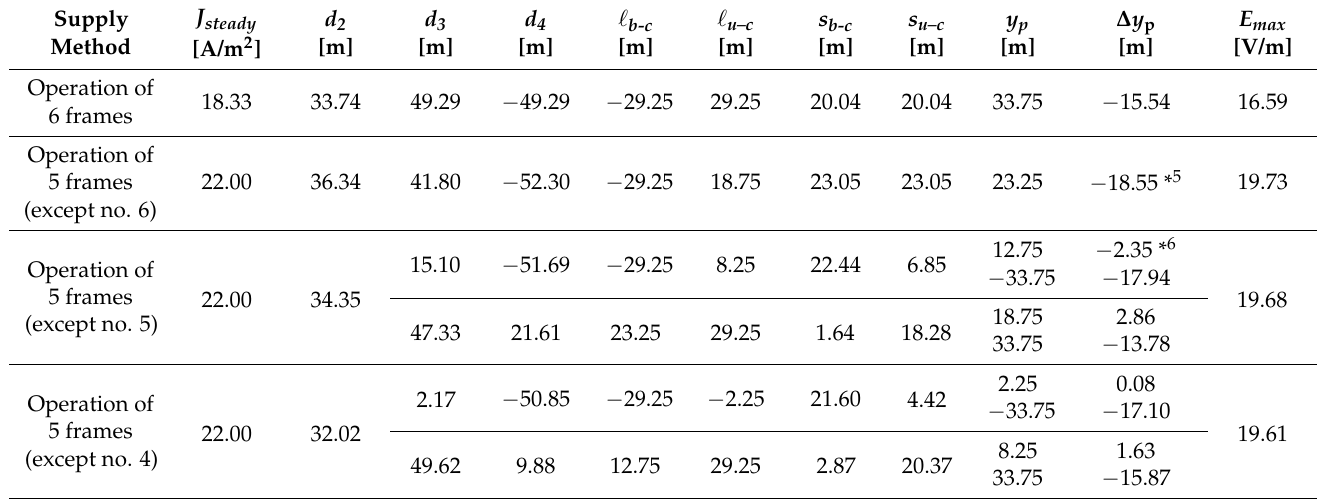
Table 14. Simulation results with method “C”, of a linear current source, for the case of an arrange- ment of 6 linear frames, in a row, consisting of 13 electrodes, for the area of Stachtoroi, Attica ( ρ S = ∞